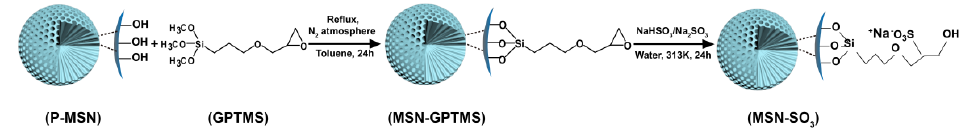
Figure 2. Schematic illustration of the synthetic route of MSN-SO 3 nanoparticles.